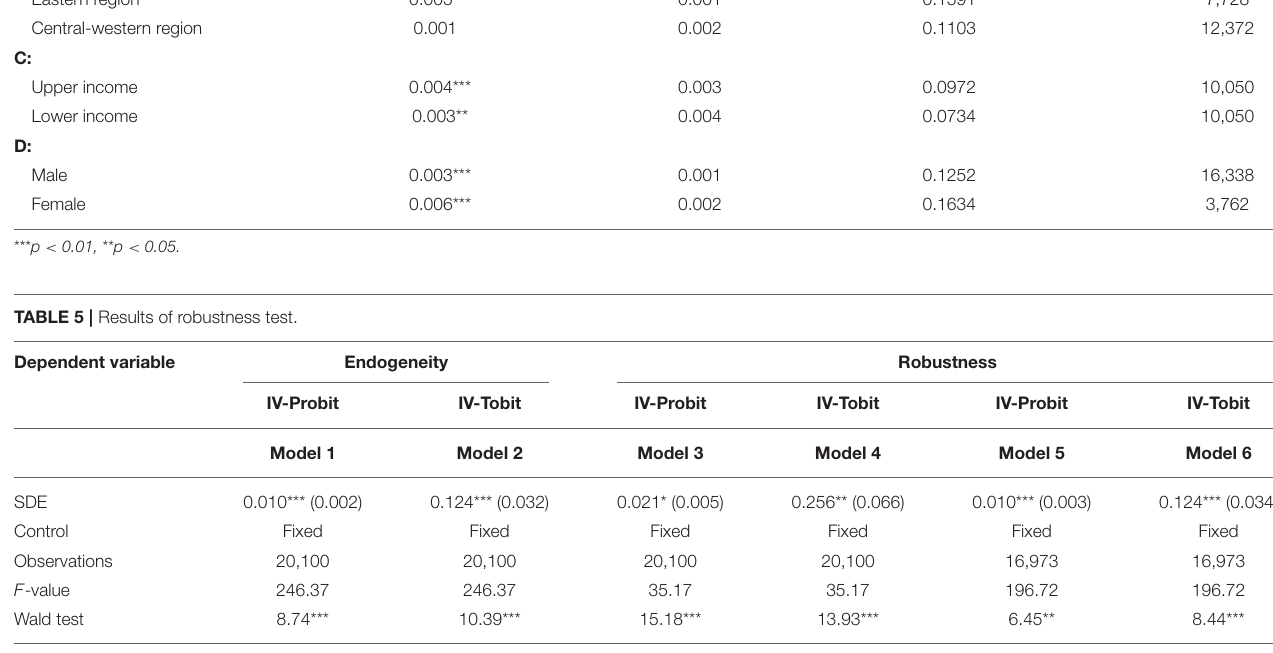
Pseudo R2 Observation